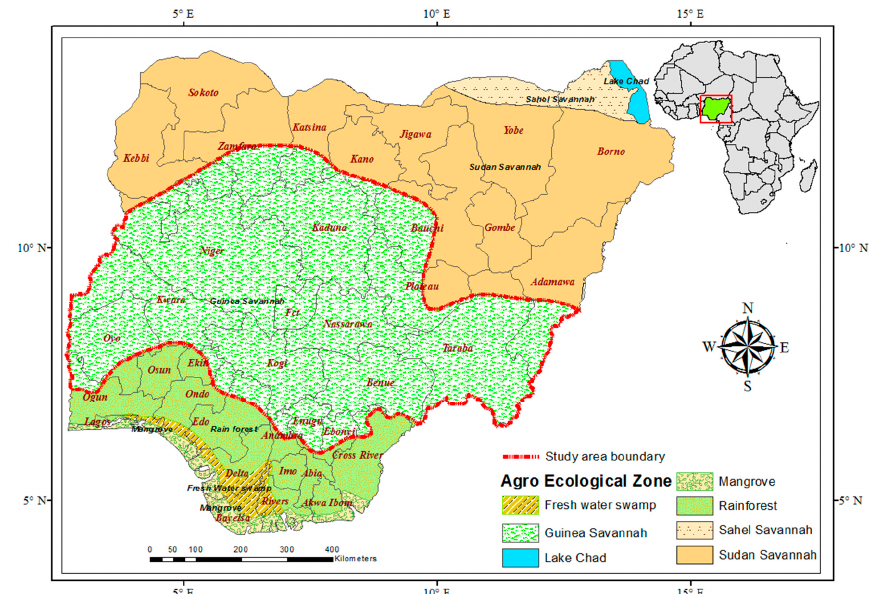
Figure 1. Map of the Nigerian Guinea Savannah including the administrative boundaries of states (Adapted from [26]).